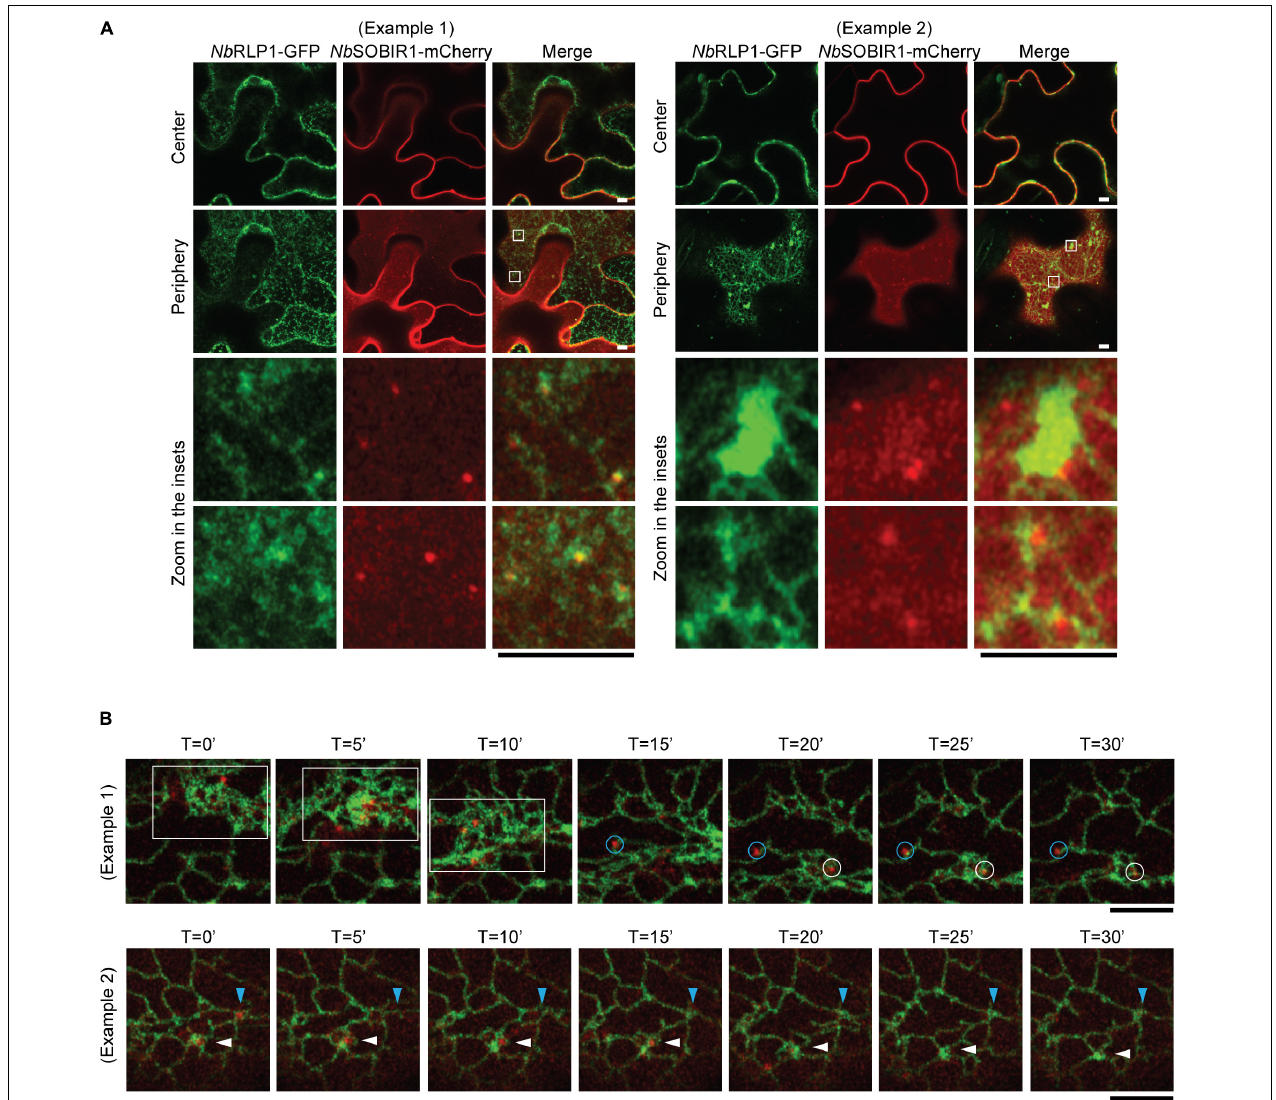
FIGURE 5 | The Nb SOBIR1 microdomains in the plasma membrane move as the cortical ER changes the morphology . (A) Nicotiana benthamiana leaves expressing Nb SOBIR1-mCherry and Nb RLP1-GFP were subjected to confocal microscopy by Zeiss LSM880 with use of Airyscan. The periphery and center sections of the epidermal cell of the same leaf were imaged, and the insets were enlarged to reveal the association between Nb SOBIR1-mCherry and Nb RLP1-GFP. Examples 1 and 2 show different degrees of ER tubules and sheets marked by Nb RLP1-GFP to reveal how Nb SOBIR1 microdomains are associated with the ER. (B) N. benthamiana leaves expressing Nb SOBIR1-mCherry and Nb RLP1-GFP were subjected to time-lapse microscopy by Zeiss LSM880 confocal microscope with use of Airyscan. The total image acquisition length was 16 min with a time interval of 5 s ( Supplementary Movie 2 ). Representative area was selected for display by time course. (Example 1) White box area, containing several Nb SOBIR1 microdomains, represents movement of these structures after a quick remodeling of the ER harboring high degree of sheets. Blue and white circles denote two Nb SOBIR1 microdomains associated with ER tubules. (Example 2) Blue and white